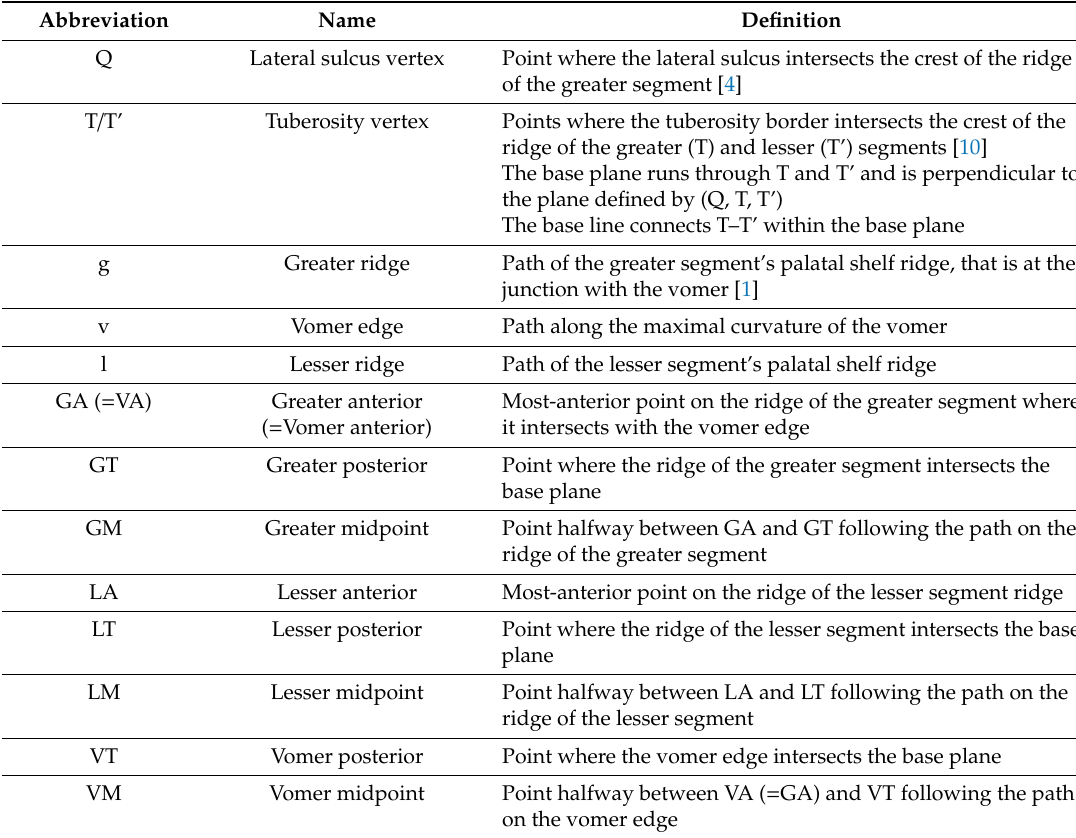
Table 1. Definition of landmarks for the 3D